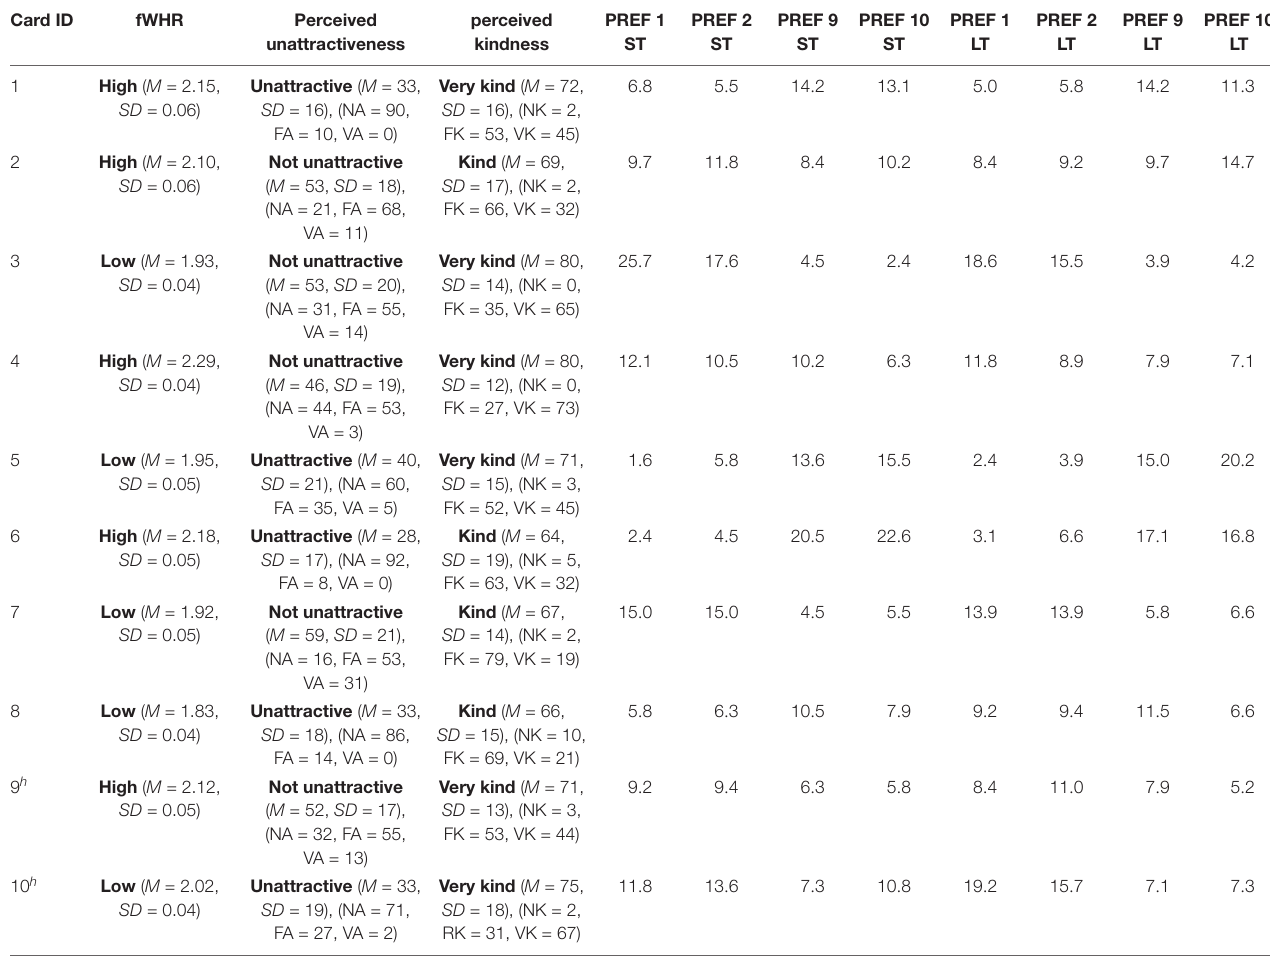
TABLE 1 | Orthogonal array and preferences by business